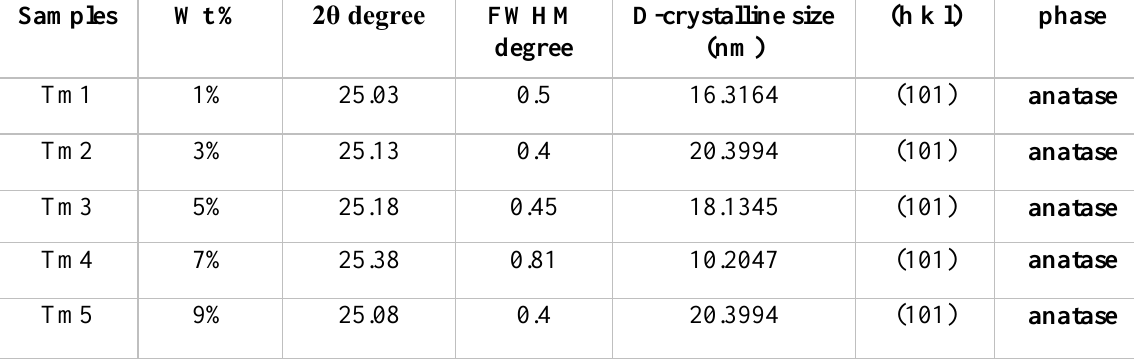
Fig.2: X-ray diffraction of pure and Mn -doped TiO Table 1: Summary of the data obtained XRD analysis on the various the prepared Mn-doped TiO2 thin films